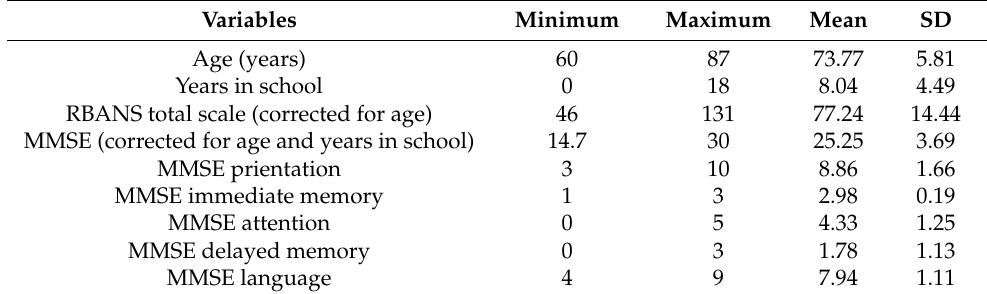
Table 1. Characteristics of the sample.